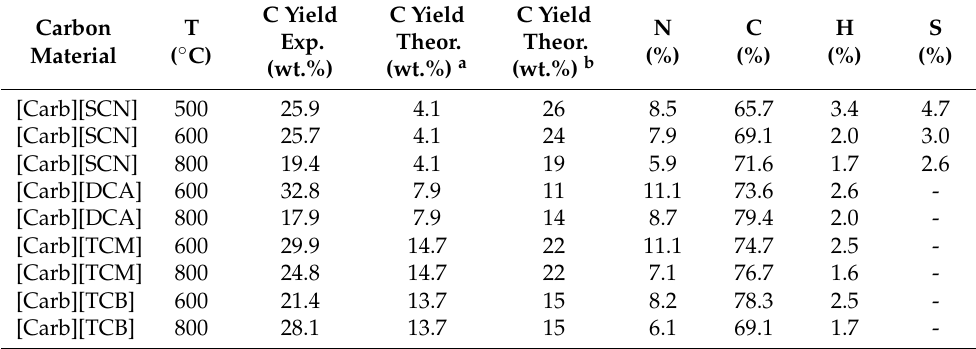
Table 2. Chemical compositions obtained by elemental analysis and yield of the carbon materials. Carbon